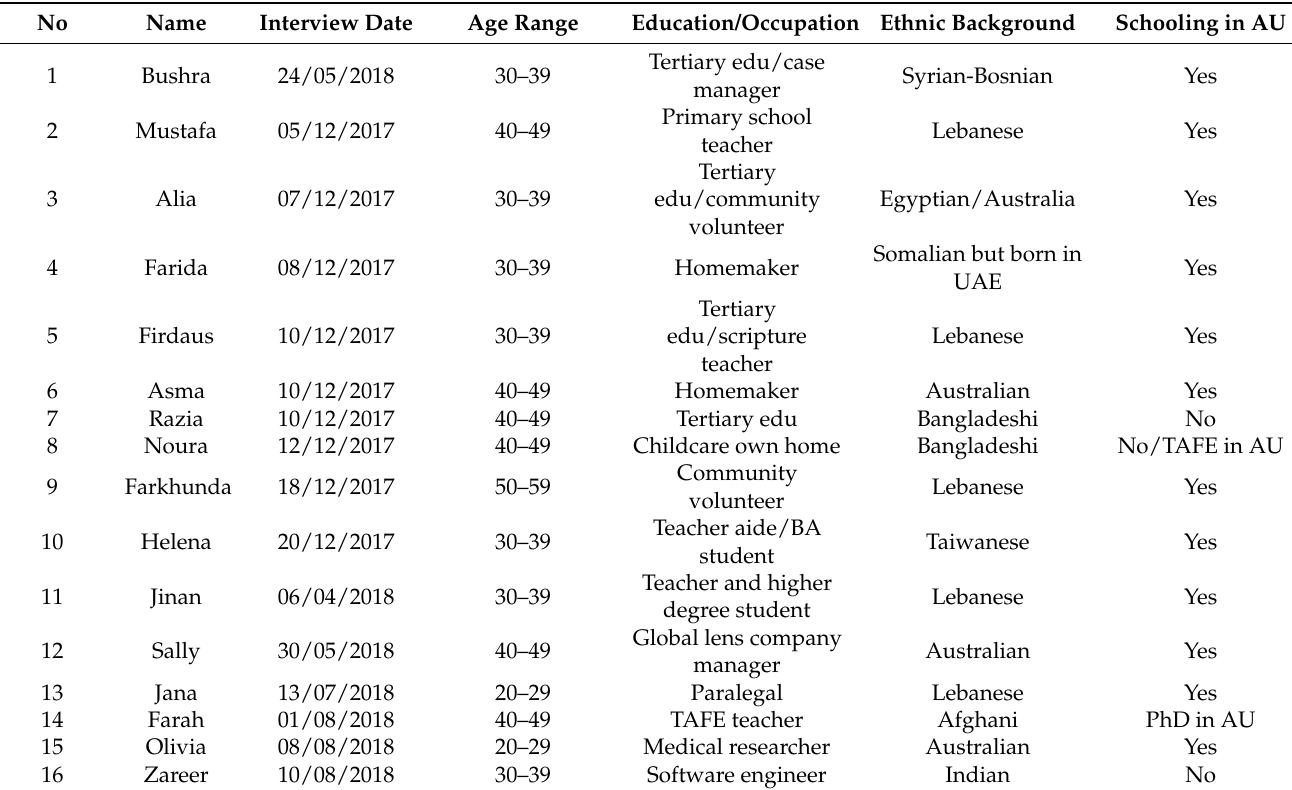
Table 1. Demographics of Interview Participants.